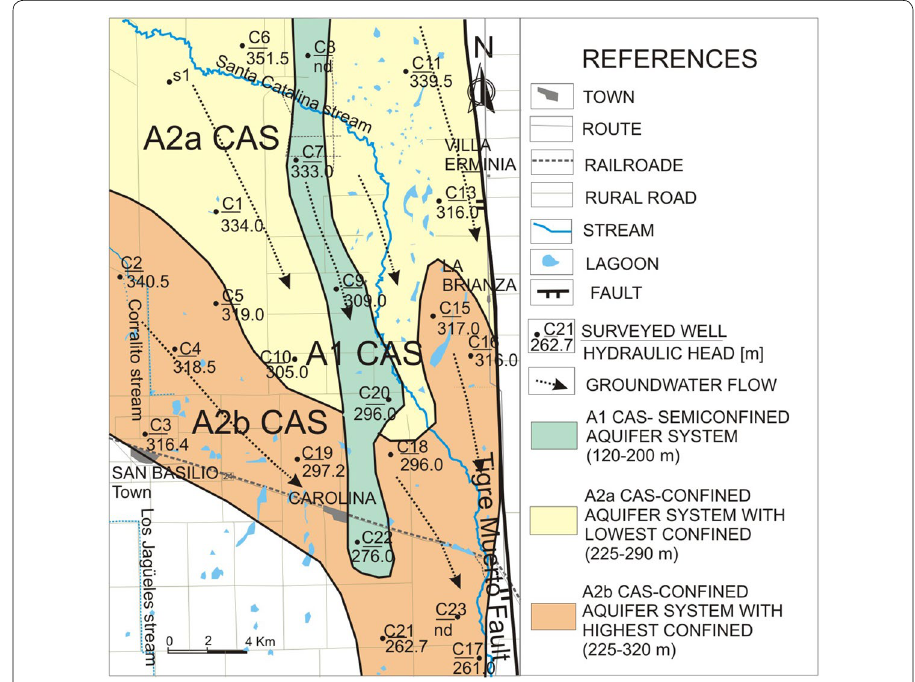
Fig. 5 Areal distribution of confined aquifer